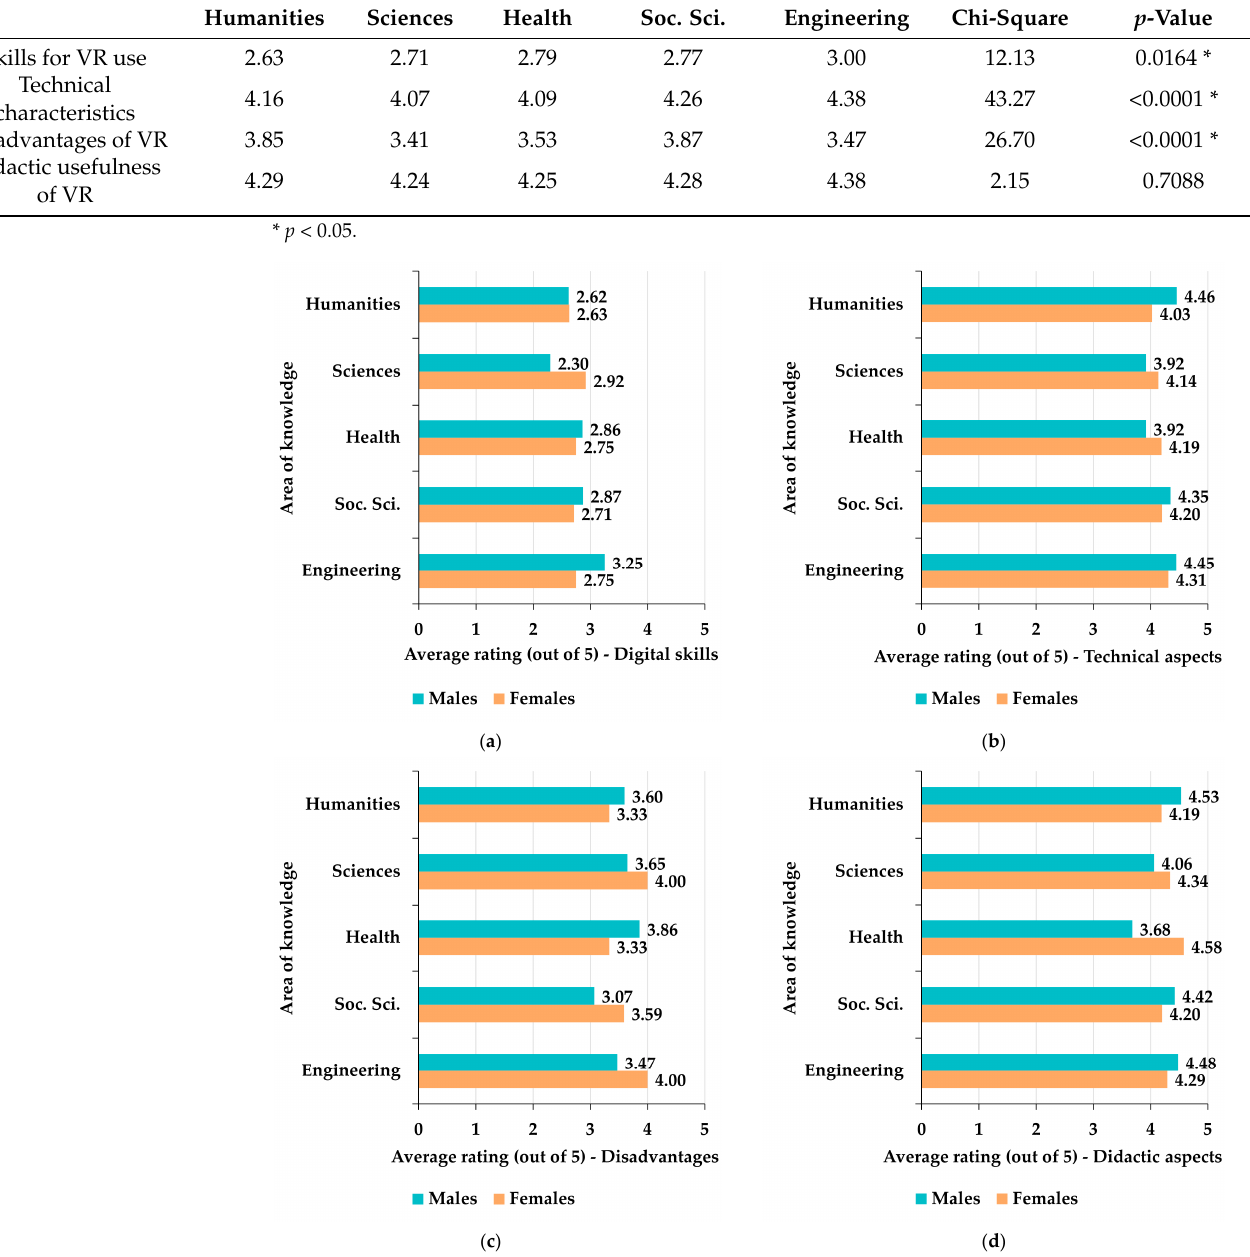
Figure 6. Average ratings, differentiated by areas of knowledge and gender, of the different families of questions: ( a ) digital skills; ( b ) technical characteristics of VR; ( c ) disadvantages of VR; and ( d ) didactic usefulness of VR.